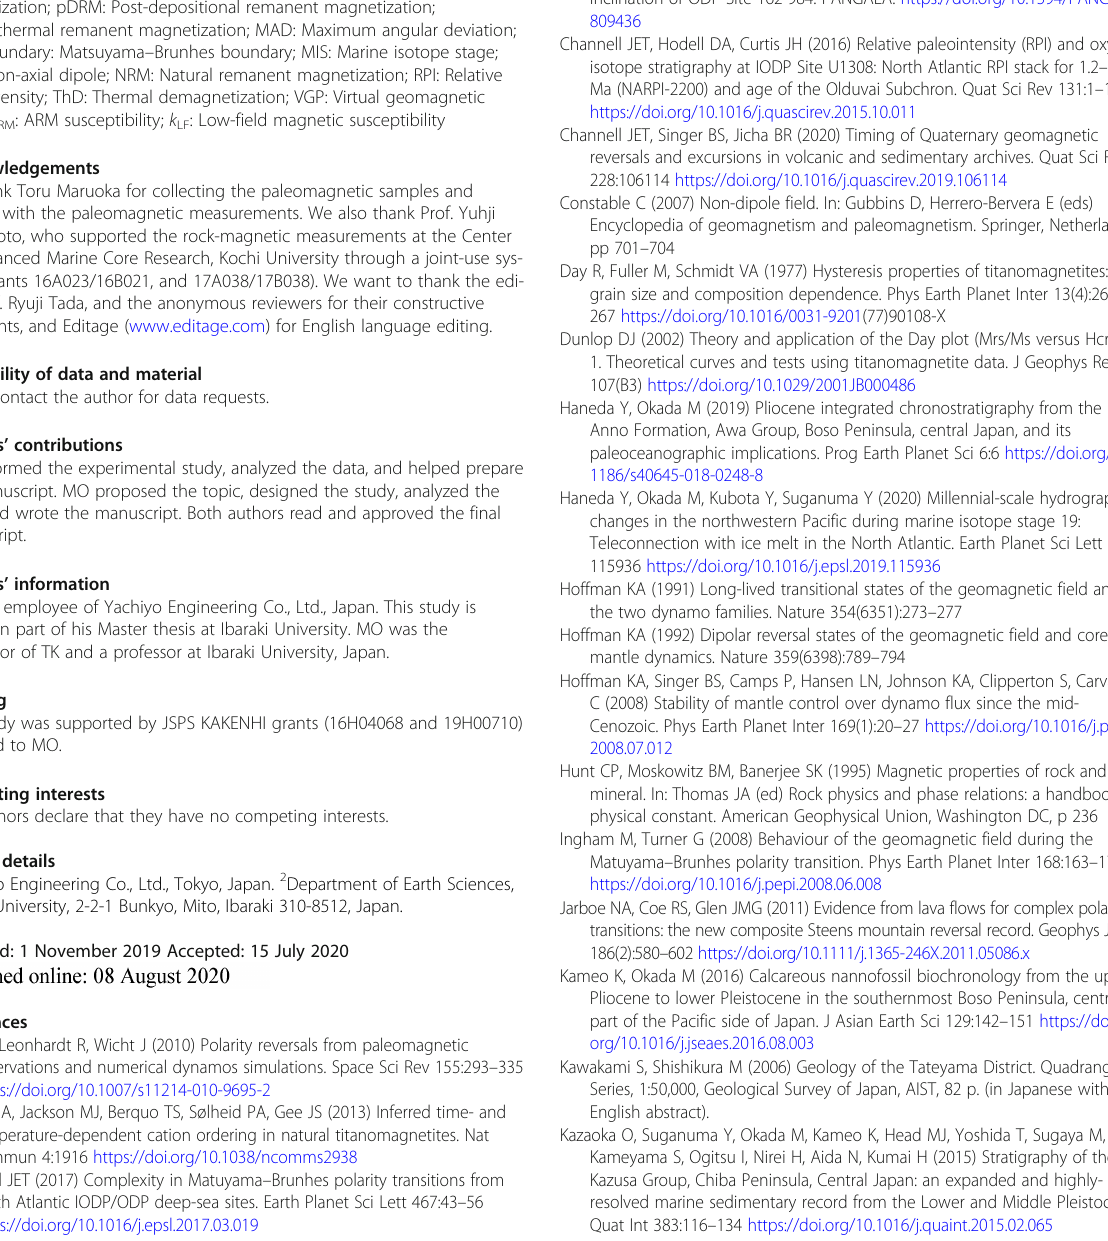
Additional file 1:. Figure S1. Detailed geologic column and sampling horizons for the geomagnetic reversal intervals; i.e., a: the upper and lower boundaries of the Réunion subchronozone, b: the lower boundary of the Olduvai subchronozone. Additional file 2:. Table S1. Paleomagnetic and rock-magnetic results for the specimens after the hybrid treatment. Note that the results of the specimens below 36 m, after the pThD treatment, are not shown in this